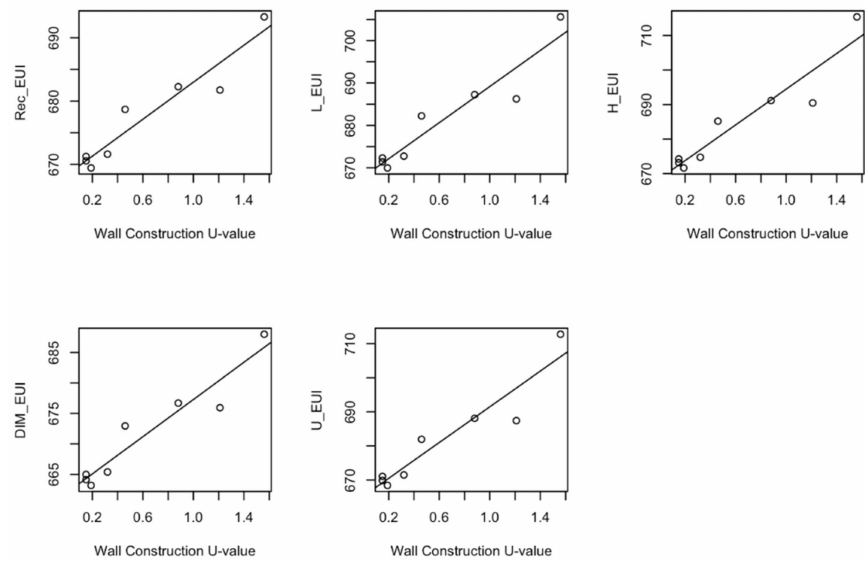
Figure 17. Wall construction fitted line diagrams.